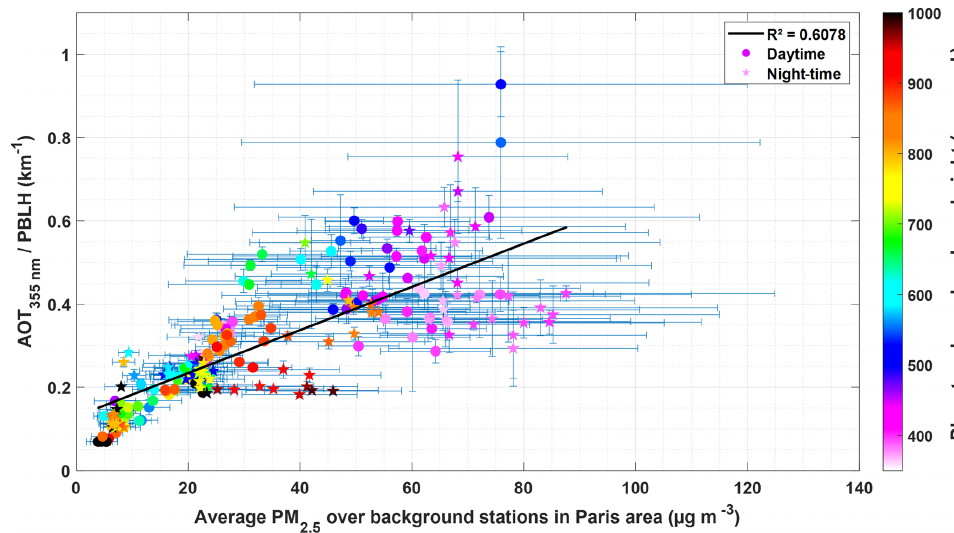
Figure 12. As in Fig. 11 but dividing AOT lid by the boundary layer height (BLH) in y axis.